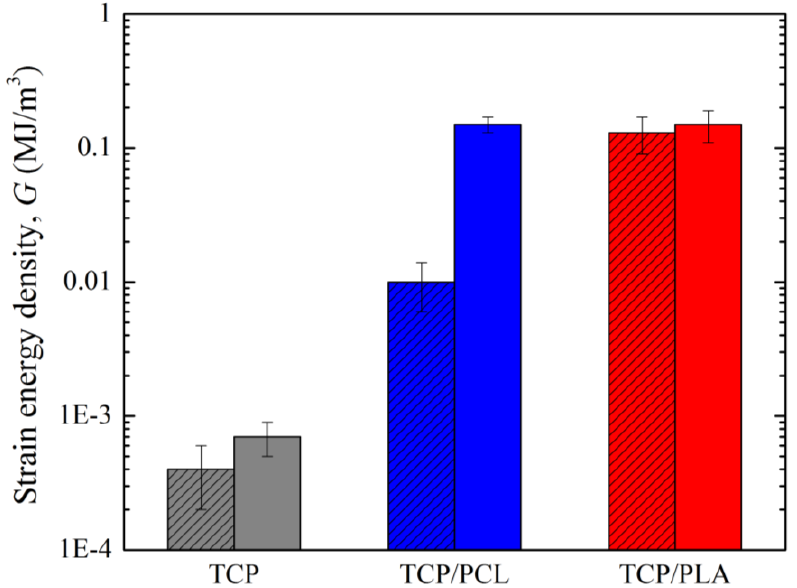
Figure 5. Strain energy density, calculated from bending test for scaffolds before and after impregnation with PCL and PLA. The patterned bars represent G ones correspond to G . Average values are shown with standard deviations as 1